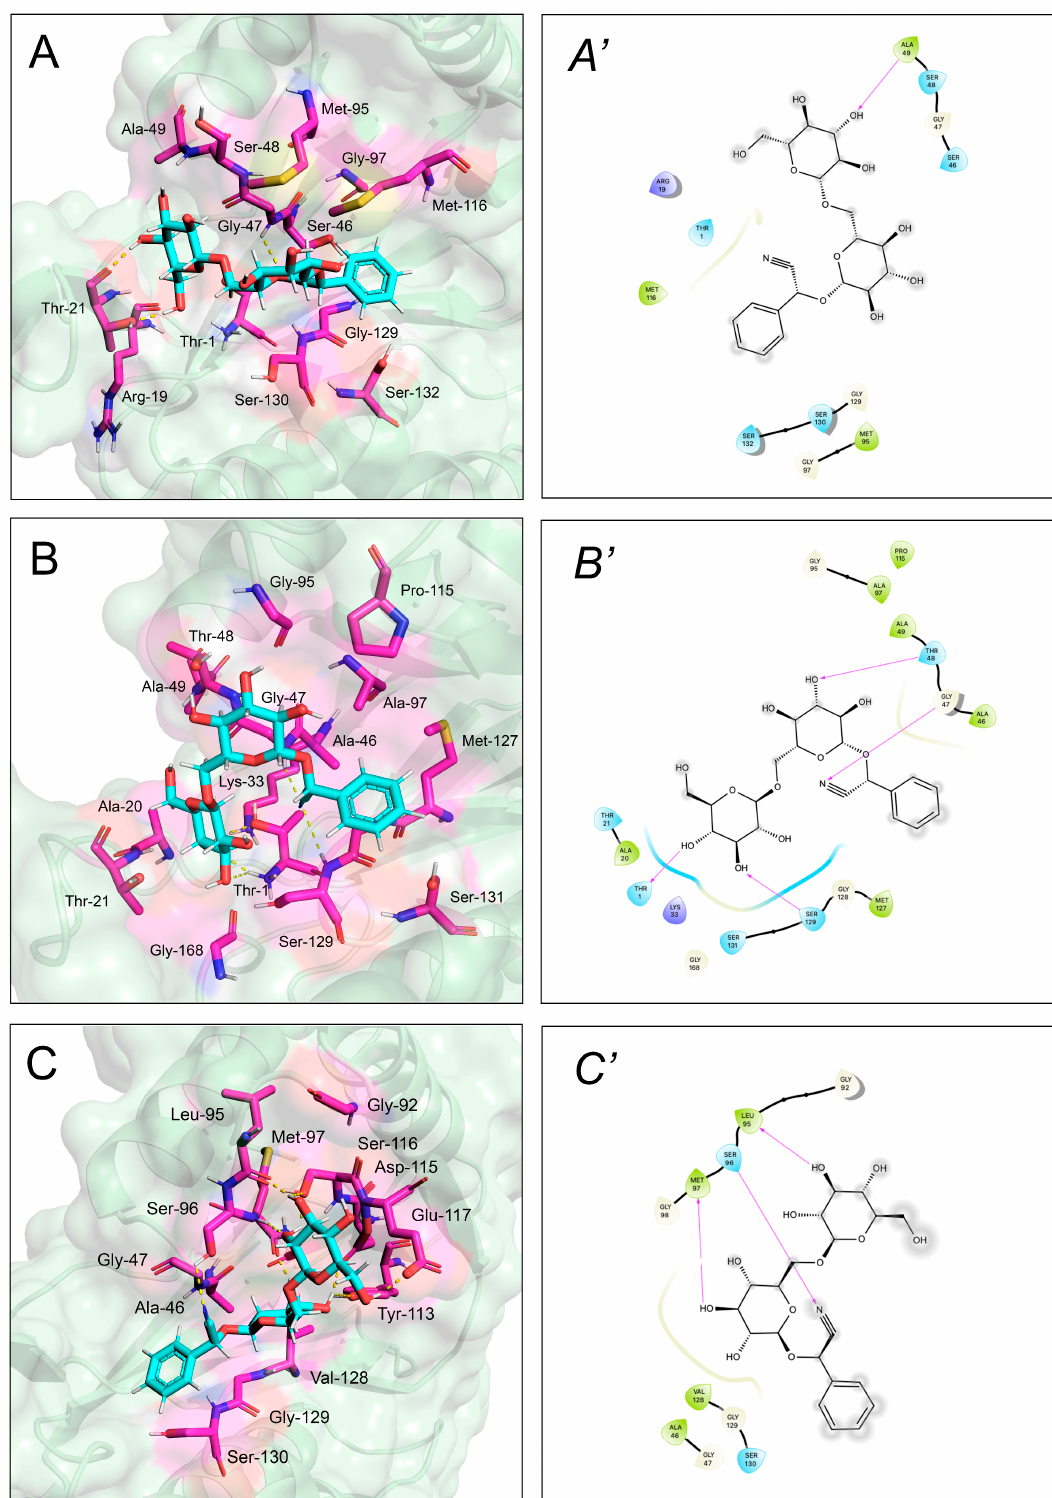
Figure 6. Computed binding modes of amygdalin to β 1, β 2, and β 5 subunits of human constitutive 20S proteasome (pdb ID: 6rgq). Panels ( A – C ) report the comparative visualization of 3D models of amygdalin and the residues close to the active sites of β 1, β 2, and β 5 subunits, respectively, that are directly involved in the formation of the enzyme ‐ inhibitor complexes (displayed as light blue and pink sticks, respectively). H ‐ bonds are indicated as yellow dashed solid lines. Panels ( A’ – C’) : com ‐ parative 2D visualization of amygdalin and the residues close to the active site of β 1, β 2, and β 5